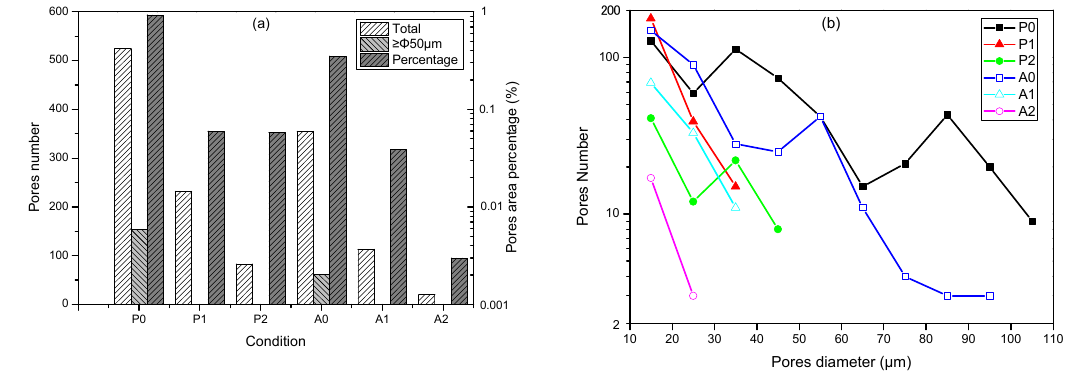
Figure 7. Characteristics of the pore distribution in WAAM 2319 aluminum alloys. ( a ) Number of pores and area percentage; ( b ) Number of pores in varied size.